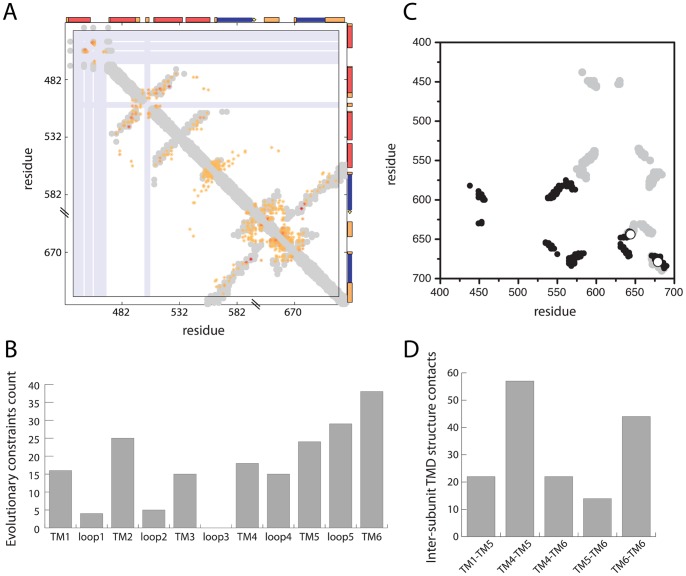
Transmembrane domain analysis for TRPV1-4.
A. Evolutionary constraints heat map for the TMD of TRPVs using rat TRPV1 as reference sequence. The colored dots indicate the evolutionary constraints. The grey shaded area indicates the tridimensional structure contacts (3J5P). B. Histogram indicating the number of evolutionary constraints for each TMD region. C. Inter-chain structure contacts for chains A–B, black, for chains A–C, grey, and chains A–D, open circles. D. Histogram indicating the number of inter-chain structure contacts for chain A against chain B, C, and D between the indicated transmembrane segments.